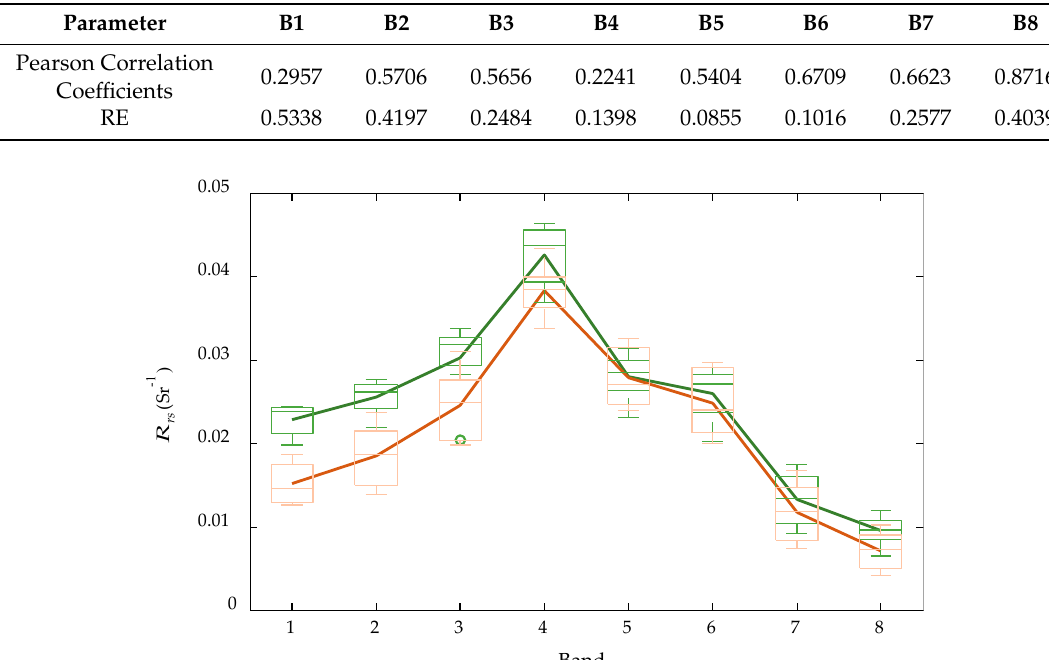
Table 3. Correlation coefficients and relative errors for each band of the atmospheric correction results.